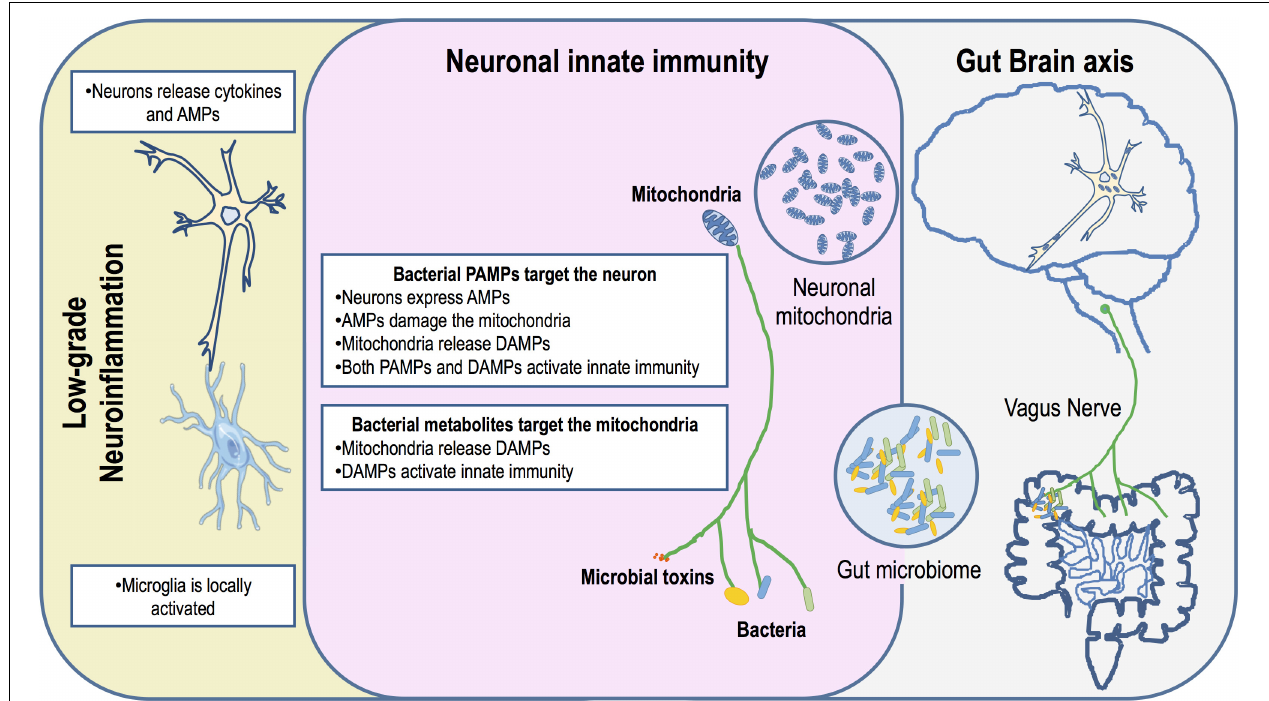
FIGURE 1 | Schematic diagram indicating that neuronal mitochondria are primary gut bacteria targets. A dysbiotic gut harbors an inflammatory microbiota that could potentiate the production of microbial toxins. Either bacteria or bacterial toxins could activate innate immunity in the ENS and CNS through the vagus nerve, the gut-brain axis. Neuronal innate immunity is triggered by bacterial PAMPs or due to mitochondrial DAMPs. Mitochondrial damage may occur through the action of AMPs produced by the neuron as an arm of innate immunity activation or by the action of antibiotics produced by bacteria. PAMPs and mitochondria DAMPs activate the NLRs and TLRs leading to neuronal production of cytokines. These pro-inflammatory cytokines are released and activate low-grade inflammation through microglia. This chronic inflammation impacts neurons exacerbating AMPs production and mitochondrial damage.